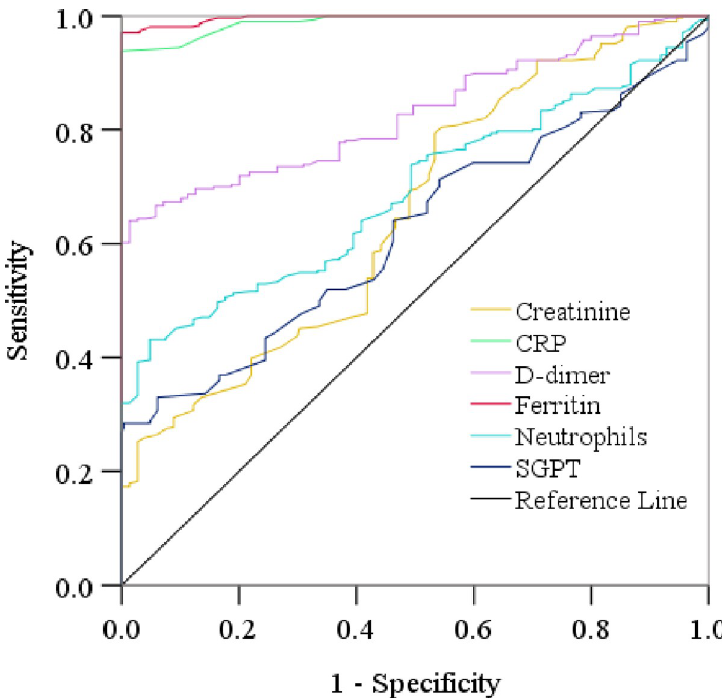
Fig 2. Receiver operating characteristic (ROC) curve is showing the relative diagnostic performances of creatinine, CRP, D-dimer, ferritin, neutrophils, and SGPTA. The cut-off points were detected for creatinine, CRP, d-dimer, ferritin, neutrophils, and SGPT as 0.30 mg/dL, 275.10 mg/dL, 120.5 ng/mL, 68.0ng/mL, and 40.5U/L, respectively.